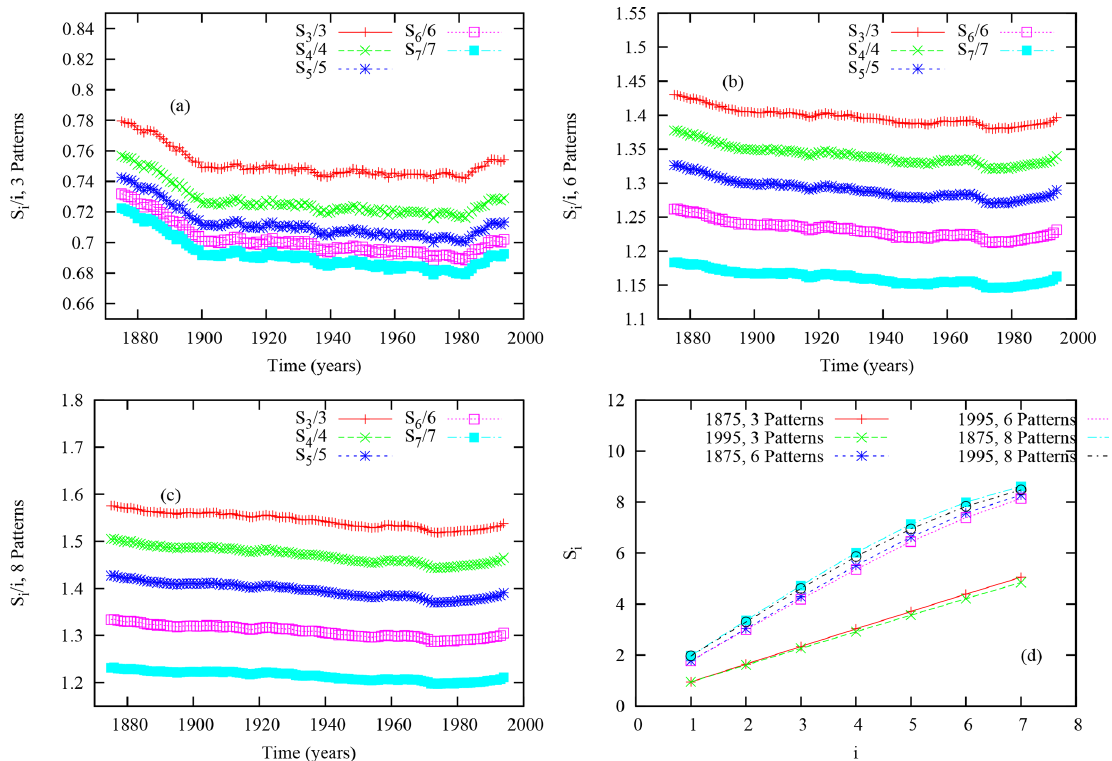
Figure 3. Temporal evolution of normalized forward block entropies, S i /i , for (a) three regimes, (b) six regimes, and (c) eight regimes. (d) Dependencies of the block entropies as a function of the length of the words, i , for the three partitions for the initial and final windows of 50 years of the observation